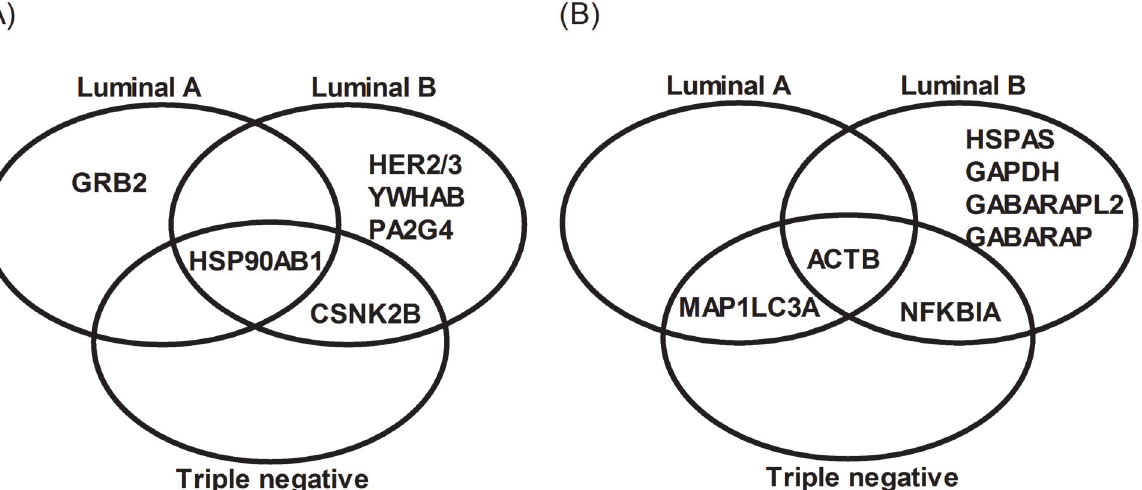
Figure 3. Venn diagram including comparative analysis of the subtype-specific networks to predict subtype-specific therapy. Up-regulated genes (A) and down- regulated genes (B). Luminal A classification includes MCF-7, T47D e ZR751 cell lines; Luminal B, includes BT-474; and triple negative, BT- 20, MDA-MB-231 and